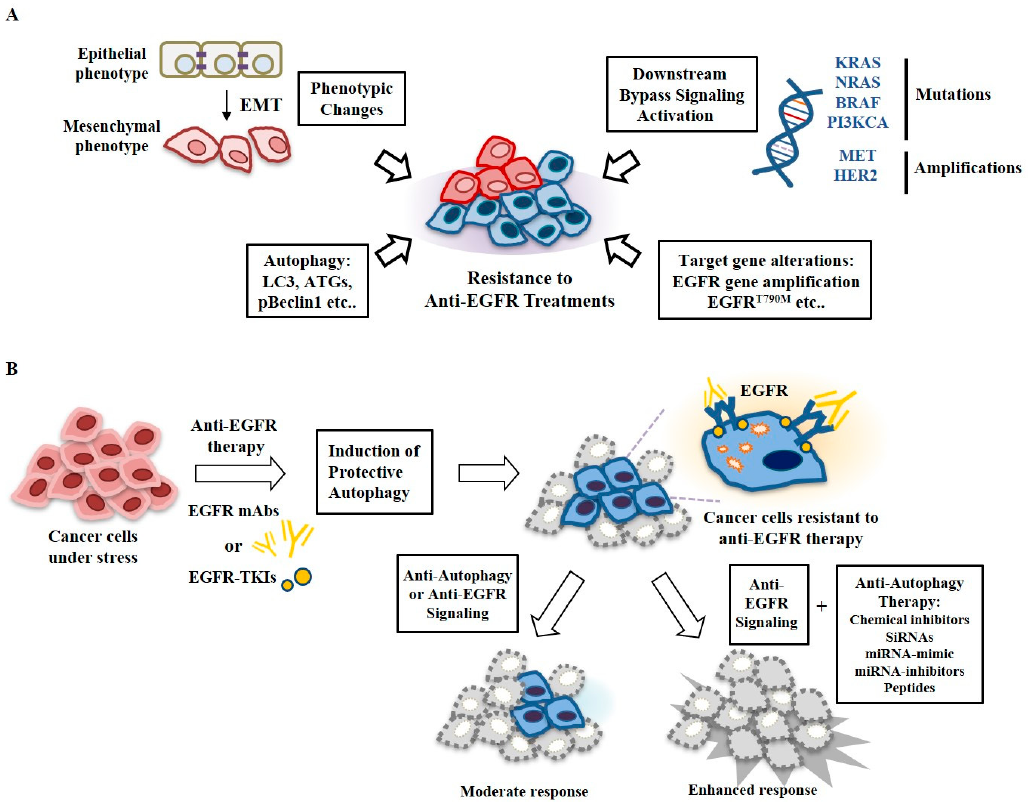
Figure 7. Targeting autophagy may overcome resistance to anti-EGFR treatments. ( A ) Resistance to anti-EGFR treatments develops from mutations and amplifications, phenotypic changes, and autophagy. ( B ) Anti-EGFR treatments such as anti-EGFR mAbs and EGFR-TKIs induce protective autophagy in cancer cells, which confers resistance to these anti-EGFR treatments. Targeting both EGFR and autophagy may overcome resistance to anti-EGFR treatments. Anti-autophagy therapy includes miRNA-mimic, miRNA-inhibitors, peptides, and small interfering RNAs (siRNAs).